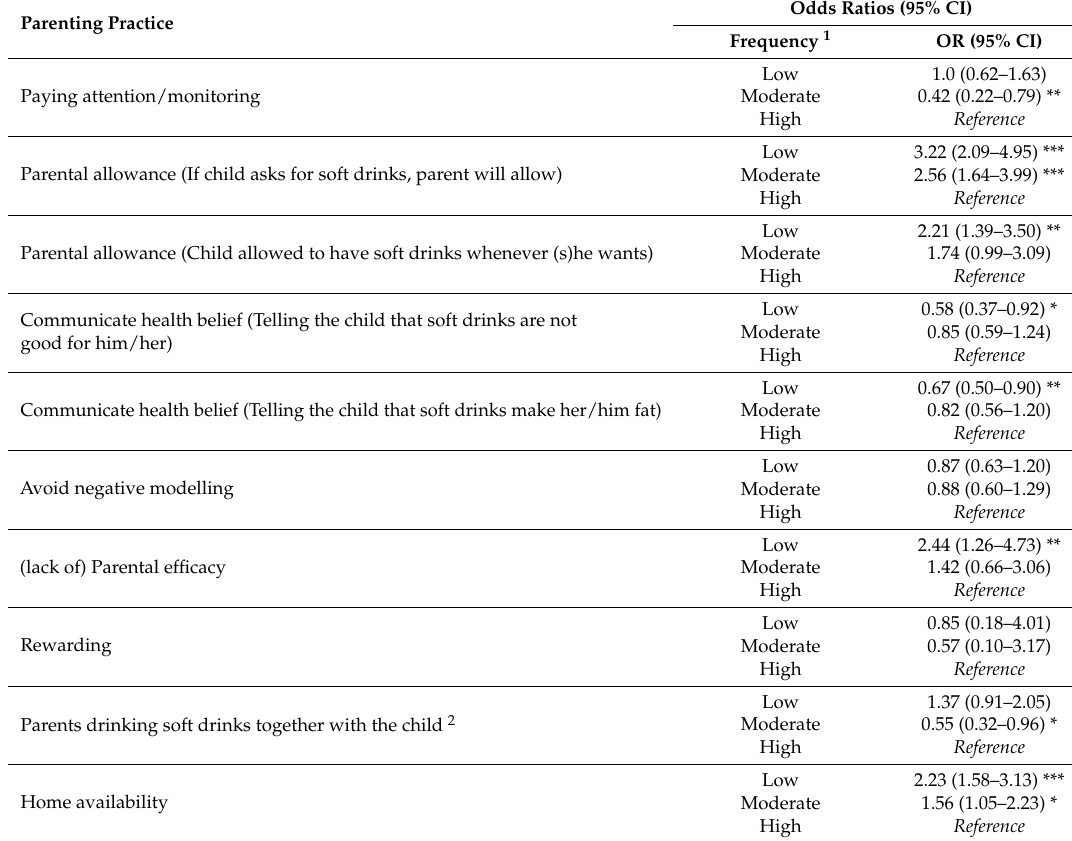
Table 4. Associations between parental practices on soft drinks and water consumption (high vs.